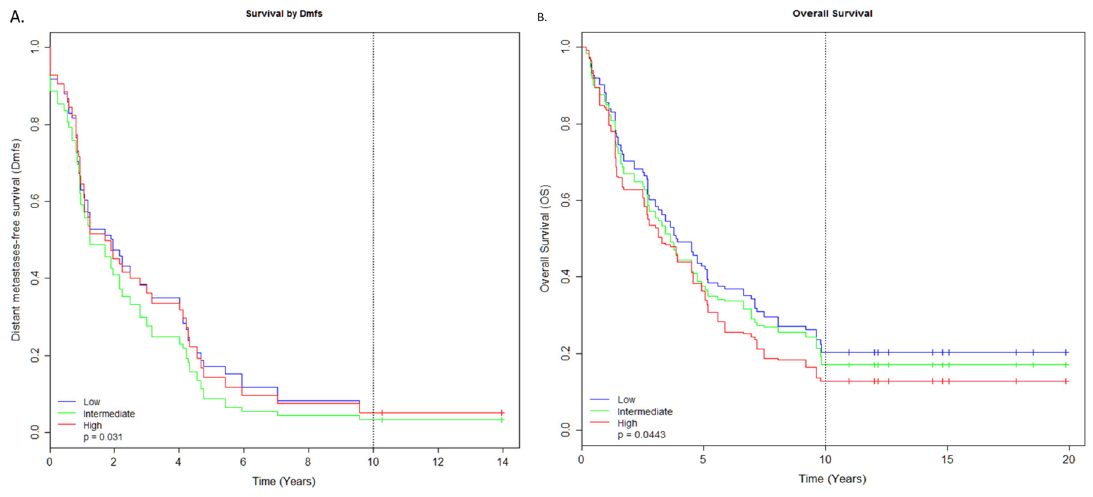
Figure 2. Figure showing the results from log-rank test among the three groups of (low, intermediate and high) expression samples. ( A ) Kaplan–Meier curves showing the difference in three groups with disease metastatic-free survival (DMFS). ( B ) Kaplan–Meier curves showing the difference in three groups with overall survival (OS). Table 2. Table showing the results of cox regression model of miRNAs significantly associated with overall survival. The regulation column represents how the trends of expression compare to non-TNBC